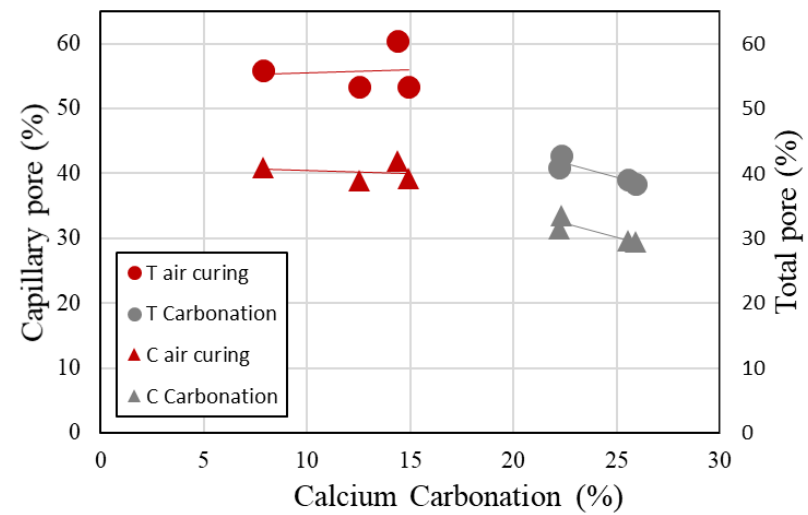
Figure 13. Relationship between the amount of calcium carbonation and the number of capillary pores and total pores in carbonated cement paste.